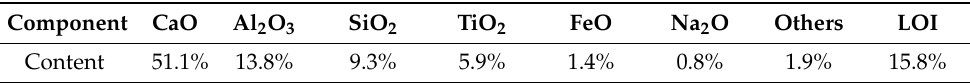
Table 7. Chemical analysis of the grey mud (dry basis) produced under the optimal conditions of